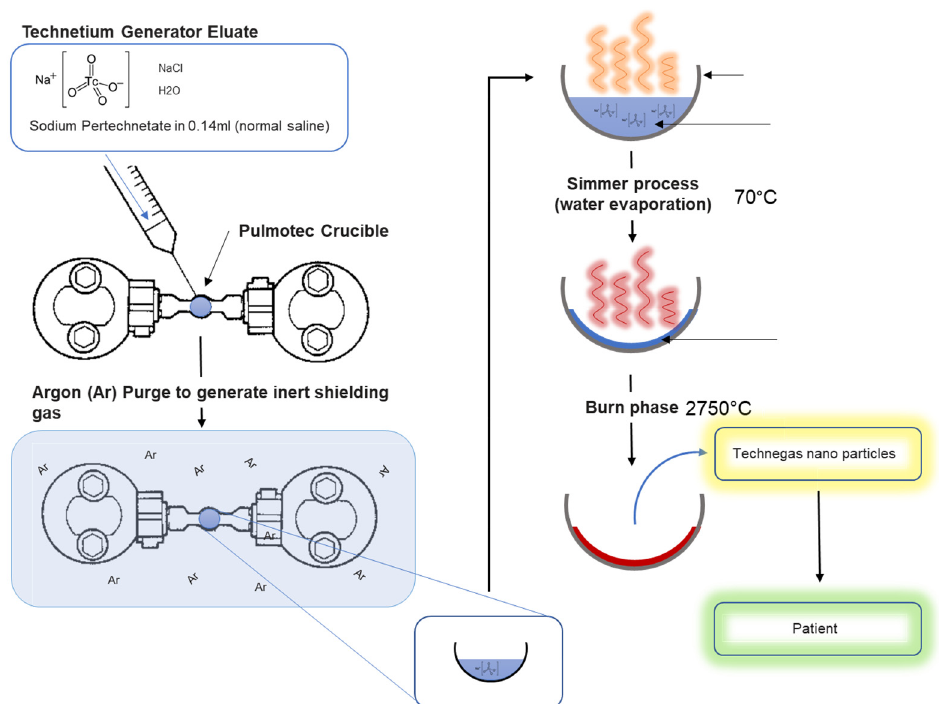
Figure 4. Macroscopic process of Technegas generation process at the crucible level.